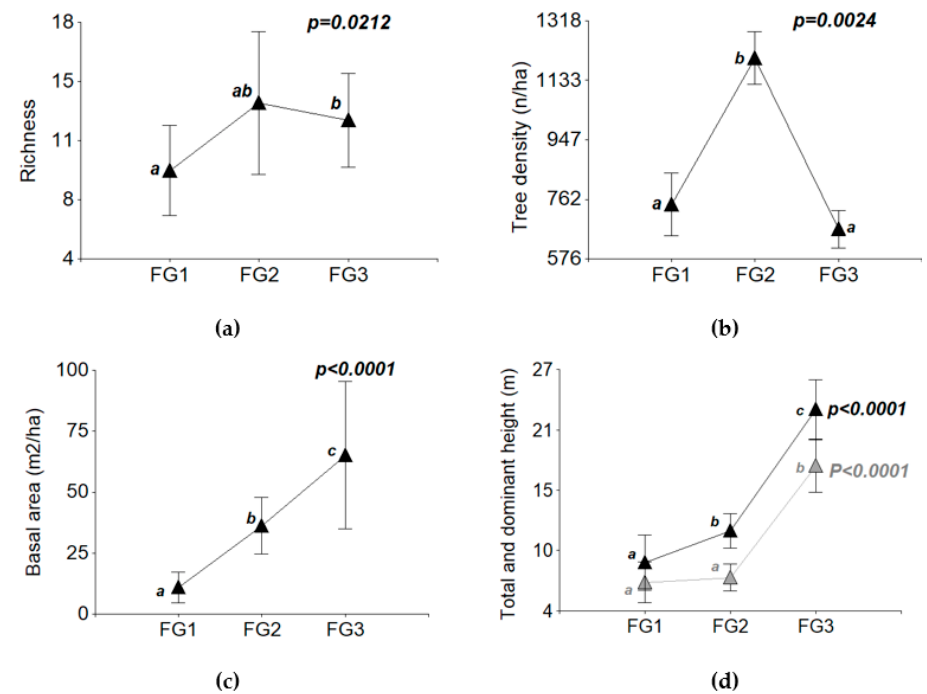
Figure 4. Mean ± standard deviation of ( a ) richness, ( b ) tree density, ( c ) basal area, and ( d ) total and dominant height in three floristic groups in the Andean forests of southern Ecuador. In ( d ), black triangles stand for dominant height and gray triangles stand for total (average) height. Different letters represent significant differences (Anova; Fisher p < 0.05). FG: floristic group.